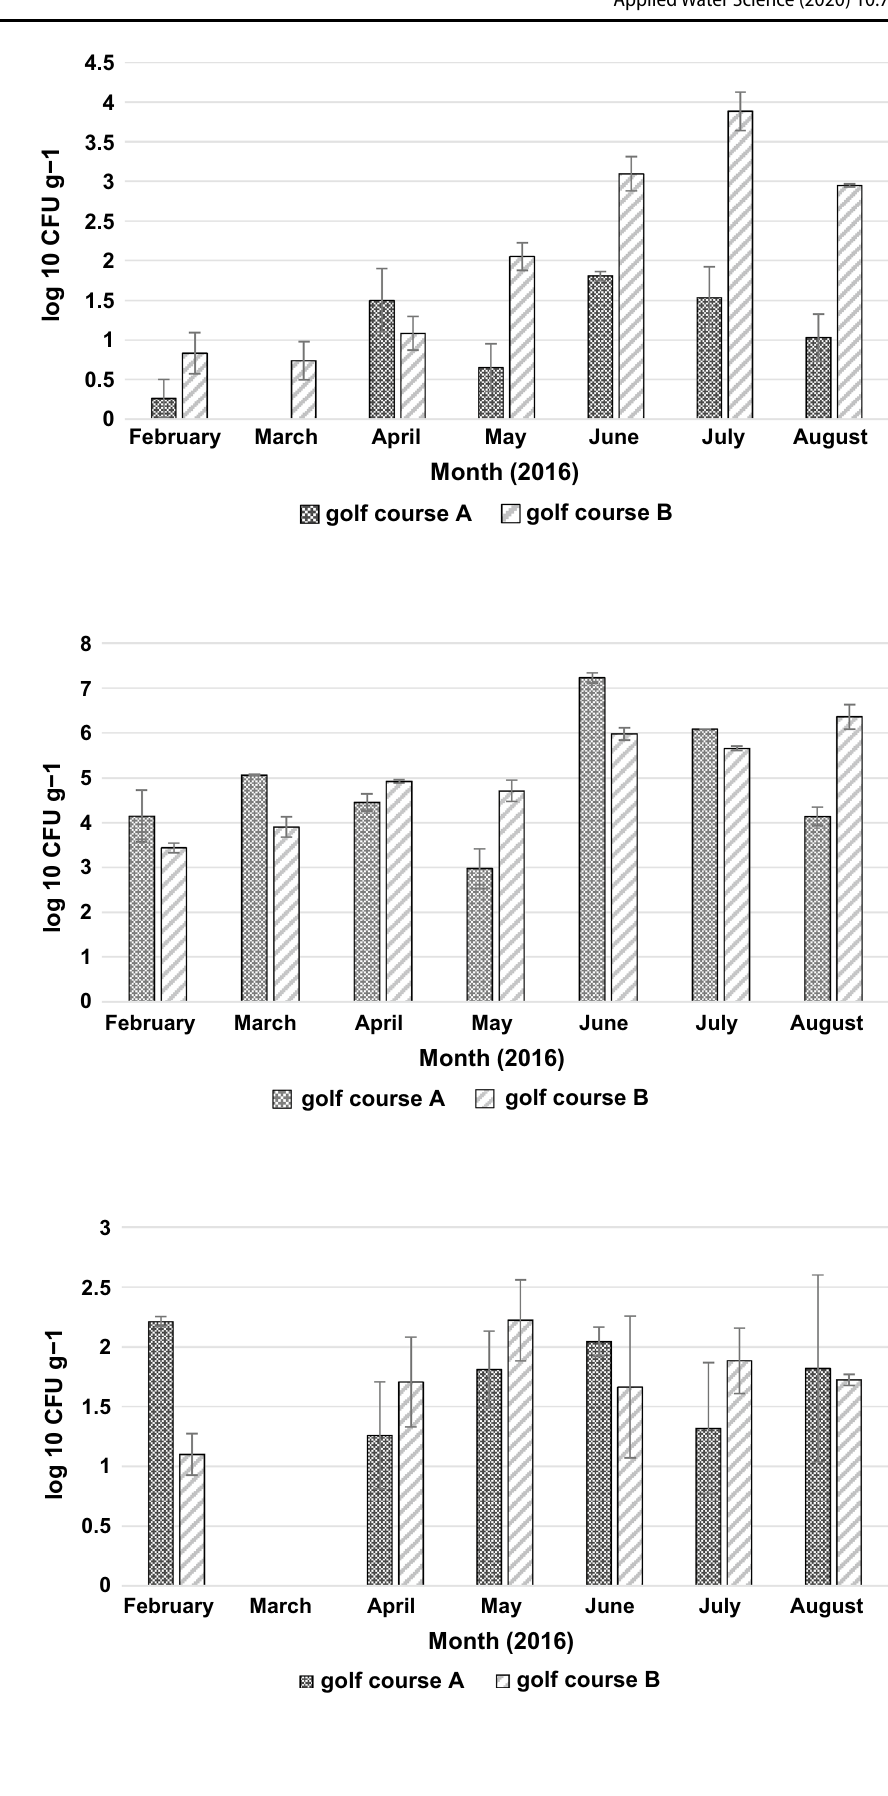
Fig. 10 Monthly variation